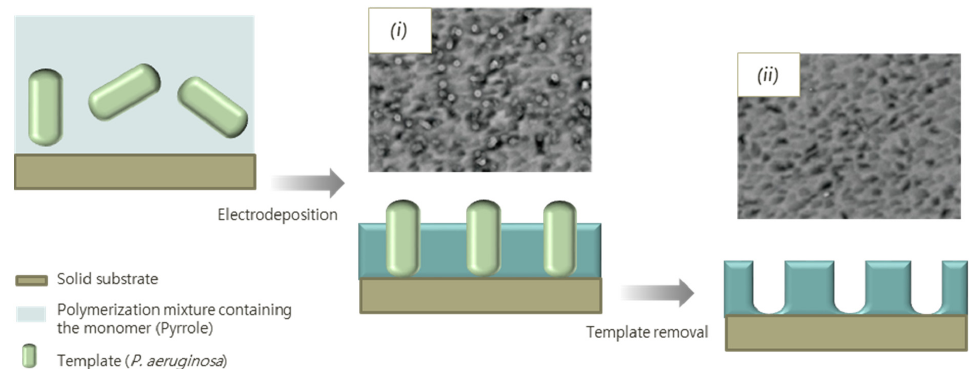
Figure 5. Schematic representation of polypyrrole imprinting with bacteria. SEM images of: ( i ) imprinted polypyrrole; and ( ii ) polypyrrole film with bacteria cavities. Reprinted (adapted) with permission from [80]. Copyright (2013) American Chemical Society.